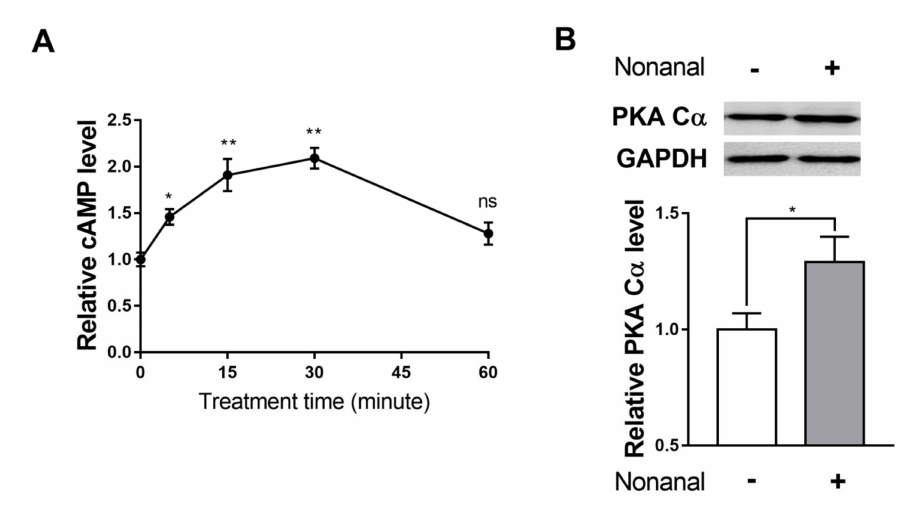
Figure 4. E ff ect of nonanal on the cyclic adenosine monophosphate (cAMP) pathway in DPCs. ( A ) DPCs were treated with vehicle or 50 µ M nonanal for 5, 15, 30, and 60 min. Intracellular cAMP levels were determined using enzyme-linked immunosorbent assay (ELISA) kit. ( B ) The protein levels of protein kinase A catalytic subunit (PKA C α ) were detected by Western blotting after treatment with vehicle or 50 µ M nonanal for 30 min. Data were statistically analyzed using the Student’s t -test. Data are presented as mean ± SEM of the results of three independent experiments. * p < 0.05, ** p < 0.01. ns, not significant.